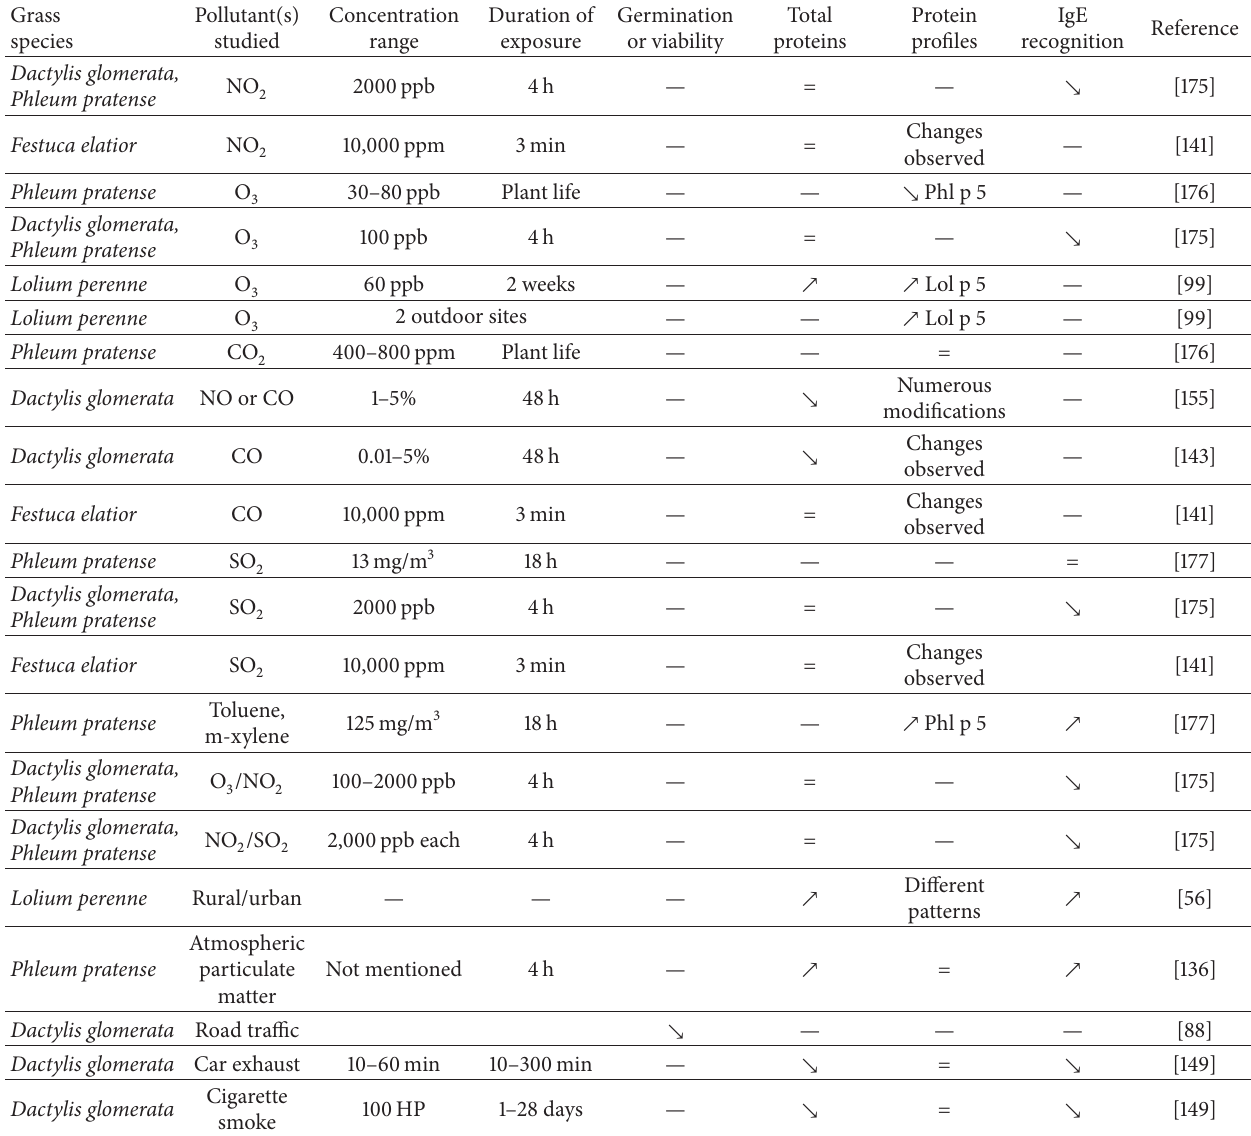
Table 2: Studies of the effect of different air pollutants on grass pollen